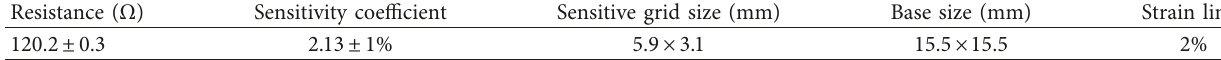
Table 1: Technical parameter of the strain gauge.